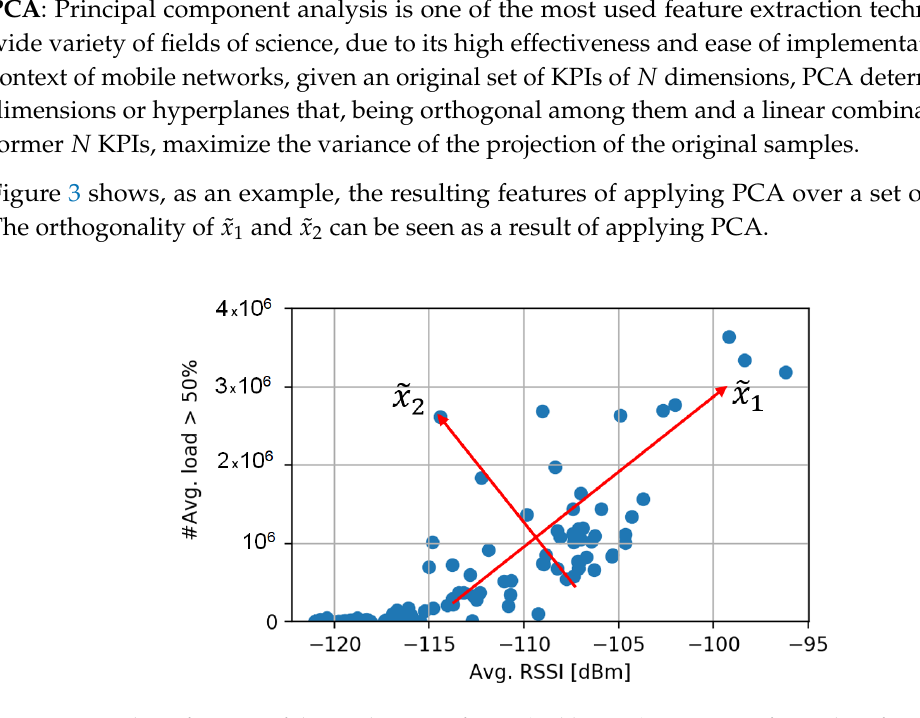
Figure 3. Resulting features of the application of PCA (red lines, ˜ x ) over a set of samples of two